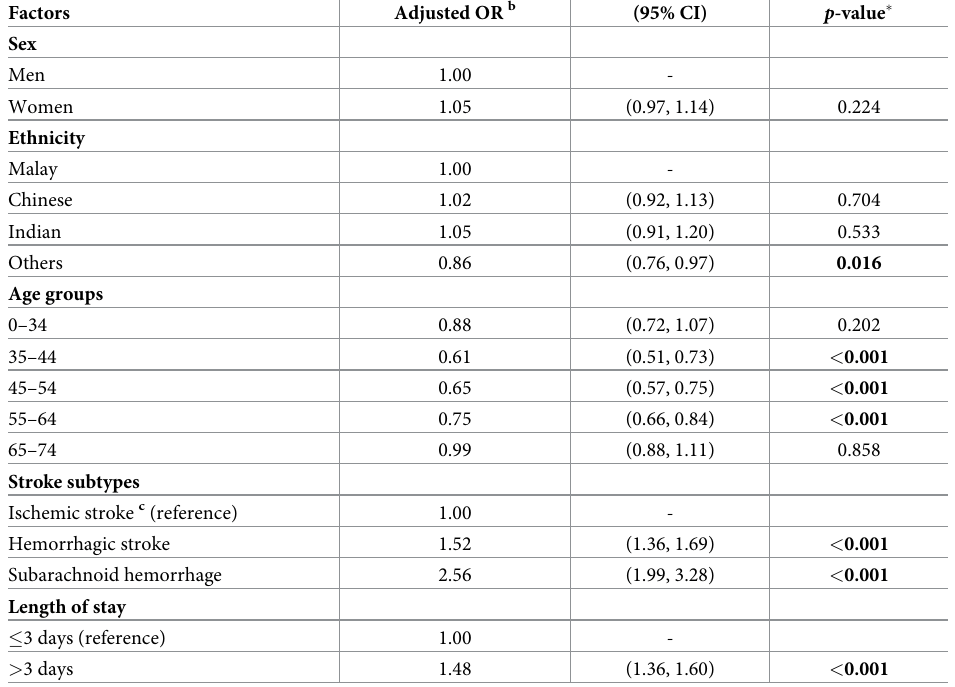
OR, odds ratio; CI, confidence interval.